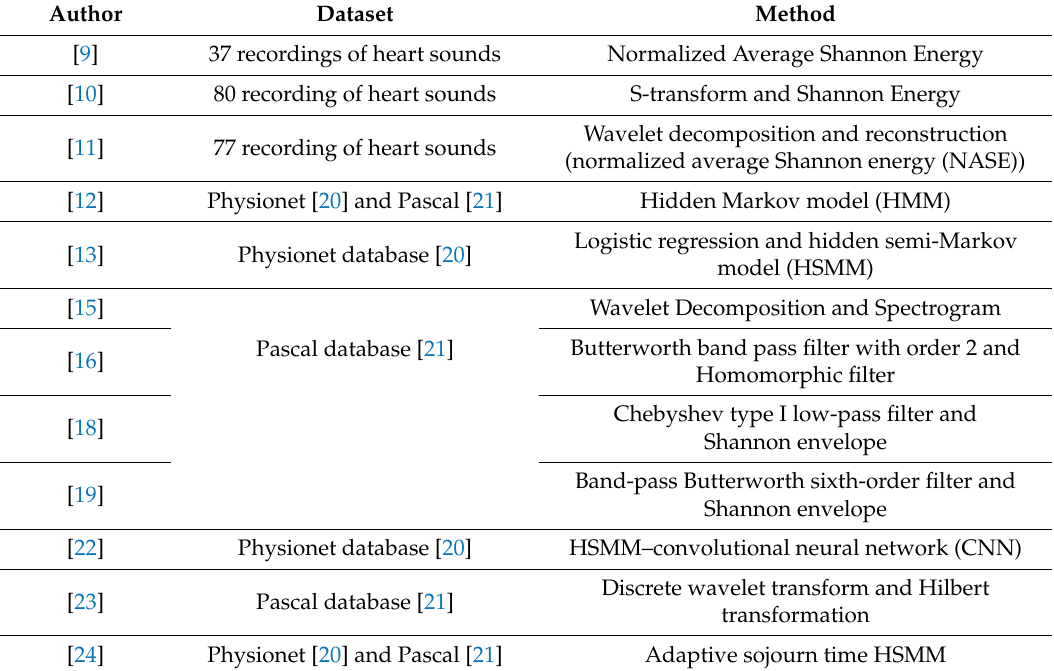
Table 1. Summary of previous work in the automatic segmentation of heart